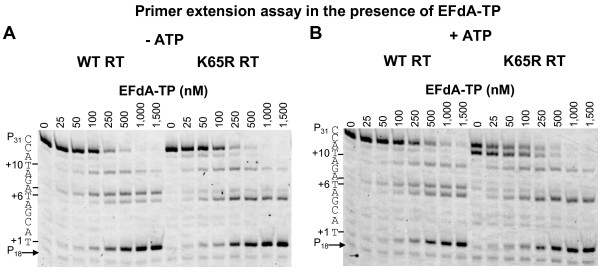
Inhibition of WT and K65R RT-catalyzed DNA synthesis by EFdA-TP. Td31/Pd18-P0 was incubated with WT or K65R HIV-1 RT for 50 minutes in the presence of 1 μM dNTPs, MgCl2 and increasing concentrations of EFdA-TP (0–1,500 nM). The experiment was carried out in the (A) absence or (B) presence of 3.5 mM ATP. The template sequence is shown next to the gels and the numbers indicate the points of EFdA-TP incorporation (+1, +6 and +10).